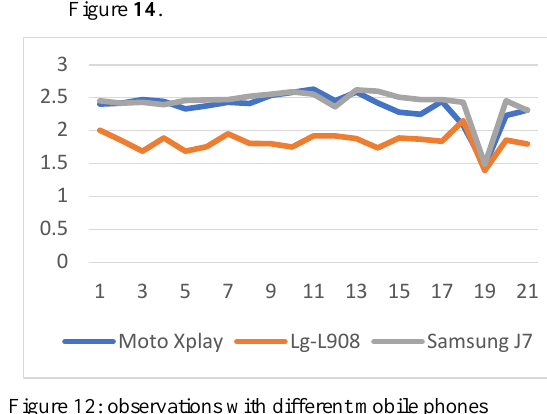
Figure 12: observations with different mobile phones